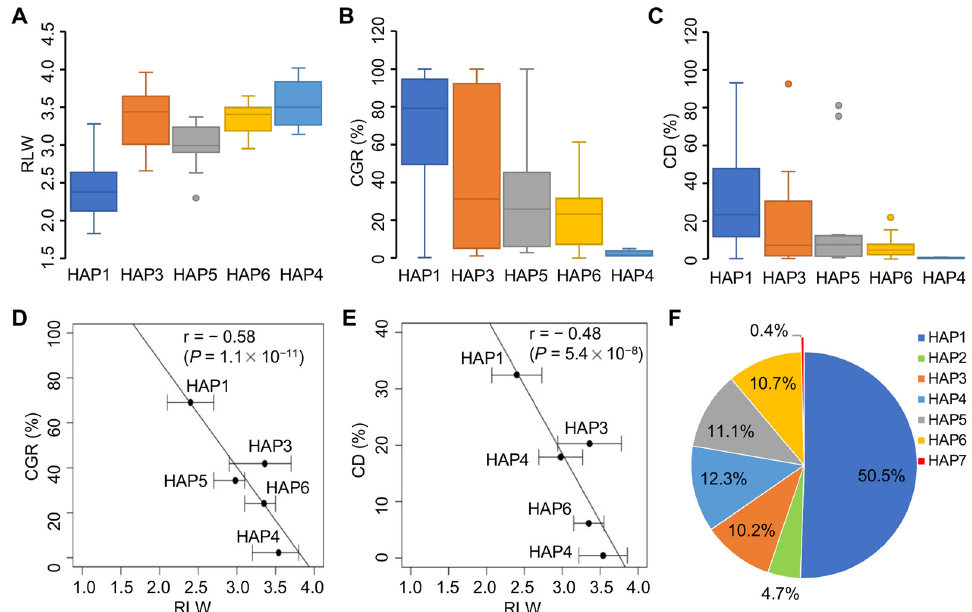
Figure 3. Boxplots showing phenotypic variation of haplotypes assayed by three genic markers in rice germplasm. ( A ) The ratio of grain length to width (RLW); ( B ) chalky grain rate (CGR); and ( C ) chalkiness degree (CD). Box edges represent the upper and lower quantile, with median value shown as bold line in the box. Whiskers represent 1.5 times the quantile of the data. Individuals falling outside the range are shown as open dots. ( D ) Correlation between RLW and CGR among five haplotypes. ( E ) Correlation between RLW and CD. ( F ) Proportions of the haplotypes in a large panel of rice accessions (n = 4694). HAP1, Chalk7 ZS /GS3 ZS /Chalk5 ZS ; HAP2, Chalk7 Cyp /GS3 ZS /Chalk5 ZS ;